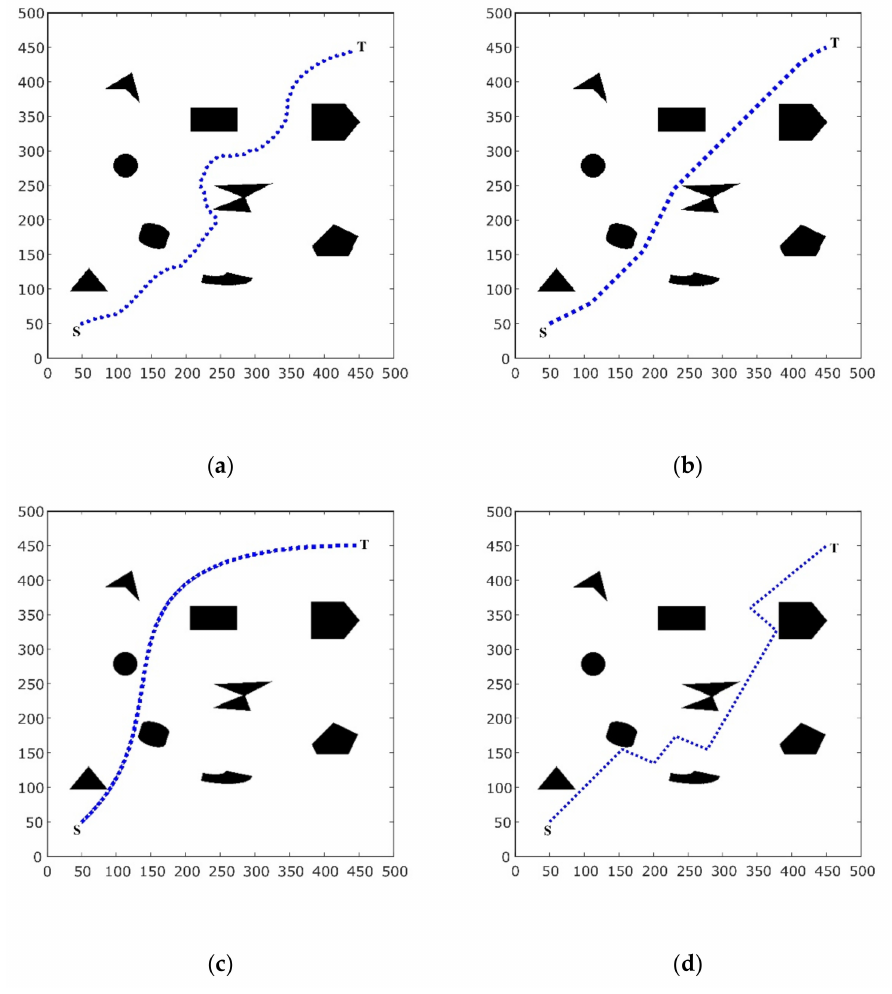
Figure 3. Environment I. The figures contain the simulation paths of the following algorithms: